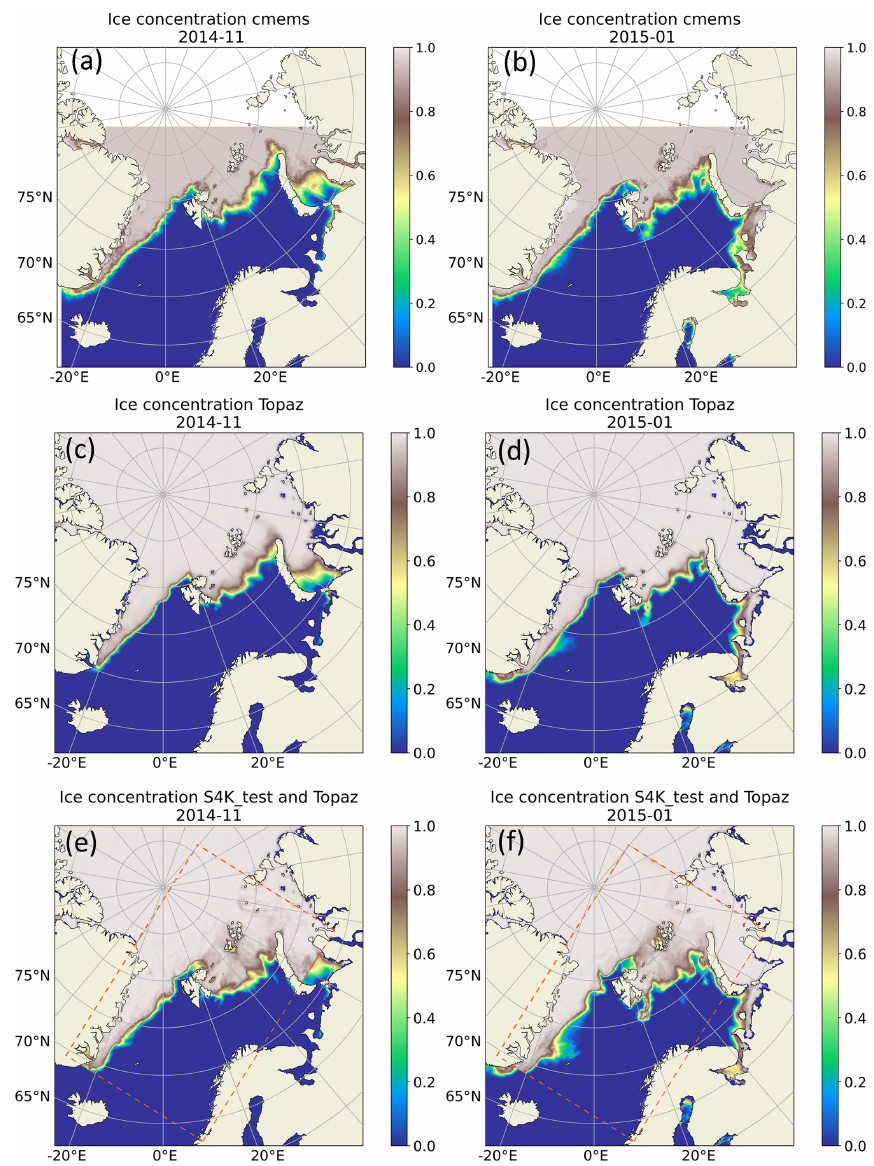
Figure 8. Dinessen and Hackett (2016) CMEMS (SEAICE_ARC_SEAICE_L4_NRT_OBSERVATIONS_011_002) (a, b) , TOPAZ (c, d) and S4K (e, f) results for monthly mean sea ice concentration fields for November 2014 (a, c, e) and January 2015 (b, d, f) . S4K fields are inserted in the TOPAZ4 model domain in the rectangle defined by the dashed line included in panels (e) and (f) (see